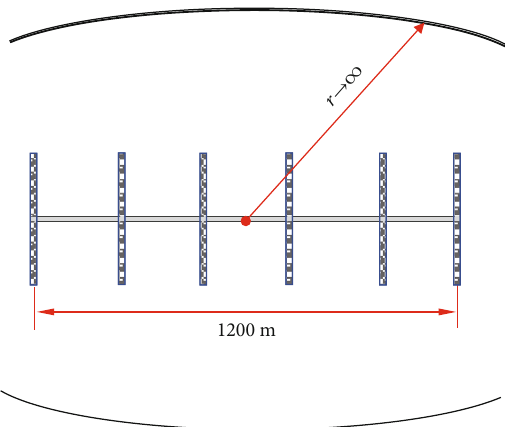
Figure 11: Schematic of a fractured horizontal well with in fi nite outer